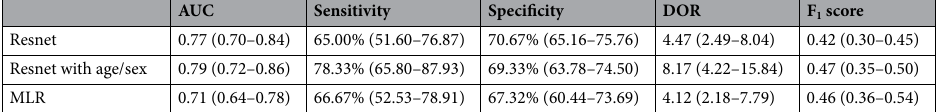
Table 3. Comparison of the performances obtained for different models, in the scenario of balancing distributions. In the scenario of balancing distributions, we compare the three models considered. To compute the metrics additional to AUC, we set a threshold for each model, as described in “Methods”. Performances are assessed according to the aggregation rule by average. 95% confidence intervals are reported in brackets. M Male, F Female, AUC Area Under the Curve, DOC Diagnostic Odd